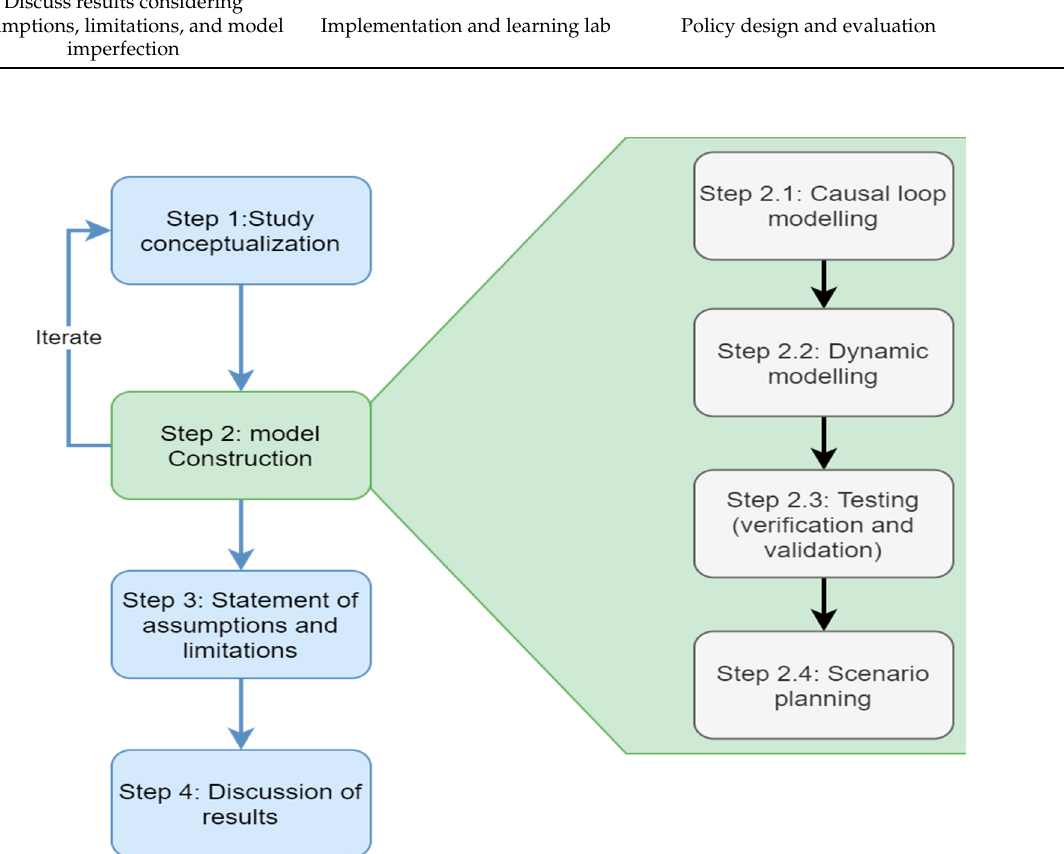
Figure 1. Depiction of the synthesized process for modelling hydrogen transitions with System Dynamics Modelling. Table 1. Summary of various approaches to modelling.